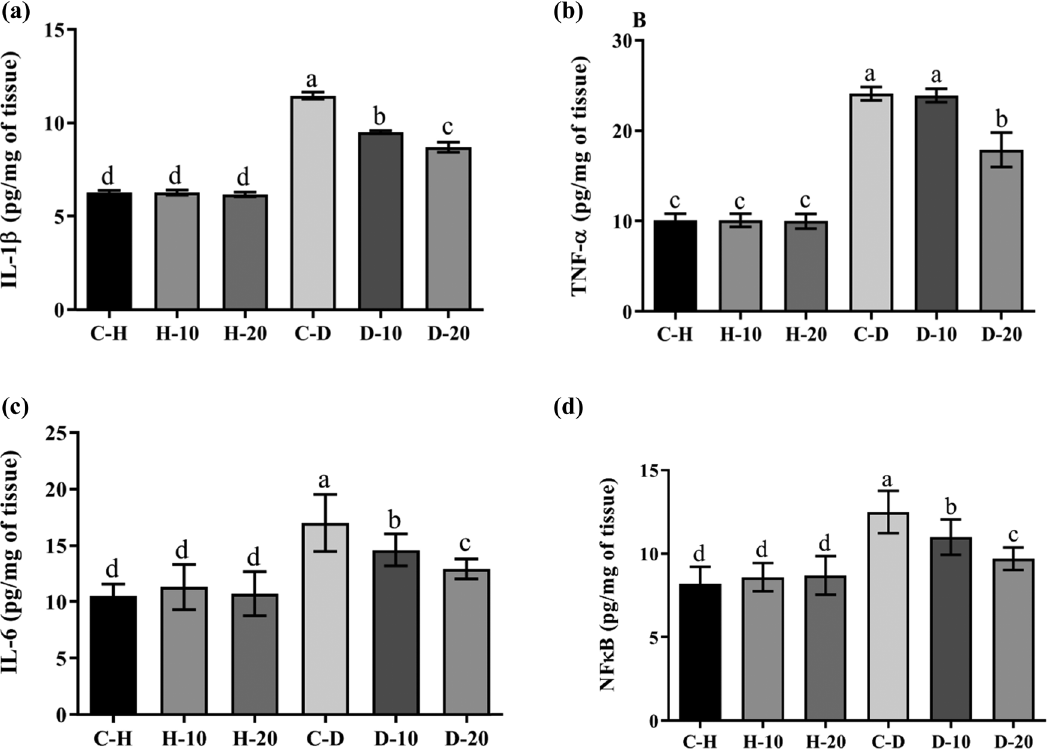
Figure 4: E ff ects of daily administration of NOM on the concentrations of IL - 1 β ( a ) , TNF - α ( b ) , IL - 6 ( c ) and NF - κ B ( d ) in diabetic and non - diabetic rats. Di ff erent superscripts ( a – d ) show signi fi cant di ff erences between the groups. The results did not show signi fi cant di ff erences between healthy animals. The administration of the NOM decreased the concentration of cytokines compared with diabetic control. C – H, H - 10 and H - 20 are healthy rats receiving 0, 10 and 20 mg/kg NOM, while C – D, D - 10 and D - 20 are diabetic rats receiving 0, 10 and 20mg/kg